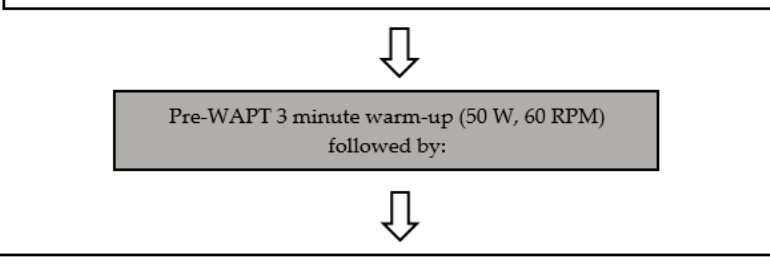
Figure 1. This figure represents a flowchart of the proposed fatigue protocol. The protocol is designed to allow analysis of rate of fatigue from the WAPT, while tracking kinetic variables across the continuum of fatigue. WAPT: Wingate Anaerobic Power Test; W: Watts RPM: Revolutions per